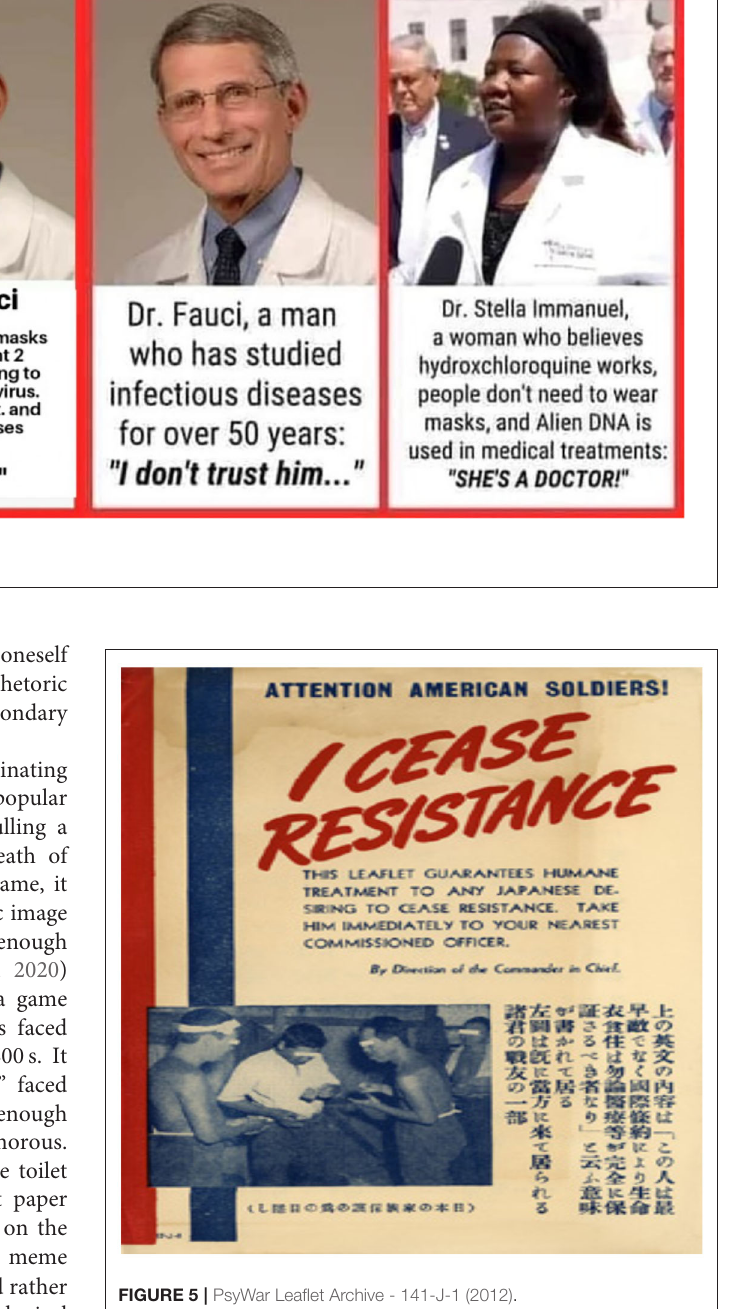
Fauci and Dr. Stella Immanuel (Liberal Logic Meme,